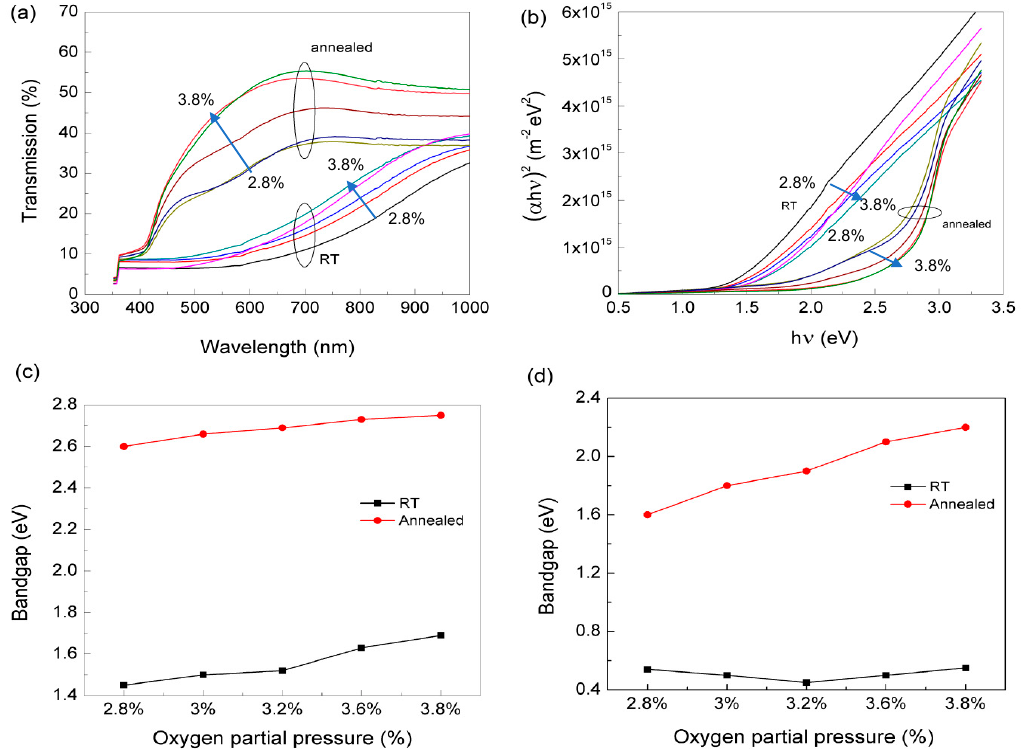
Figure 3. ( a ) Optical transmission of as prepared and annealed SnO x films. ( b ) Plot for the estimation of the direct band gap estimation; Dependence of the estimated direct ( c ) and indirect ( d ) band gap on O pp used, before and after annealing the films for 30 mn.